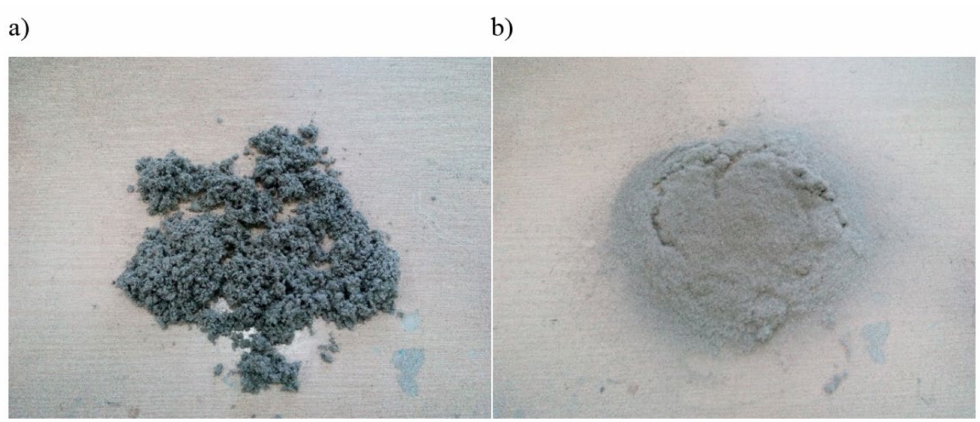
Figure 1. Hemp fibers alkalized with 10% NaOH solution: ( a ) before sieving, ( b ) after sieving. Eight types of PHBV matrix biocomposites with the following markings were pro- duced in the extrusion